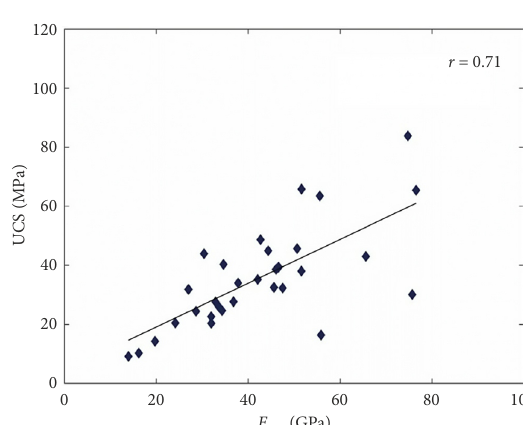
Figure 8. Compressional wave velocity versus shear wave velocity